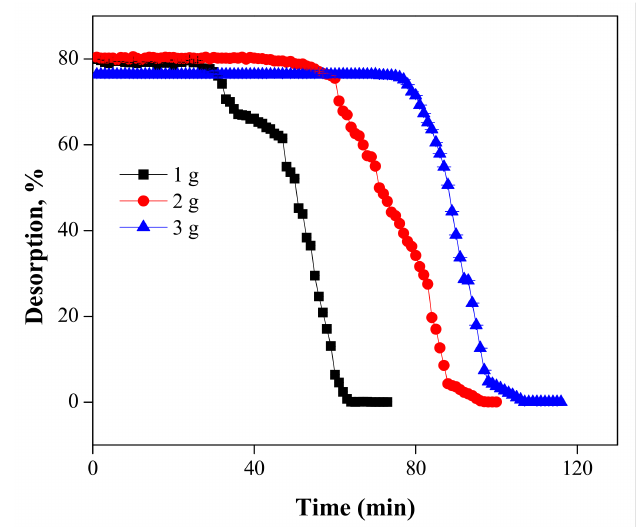
Figure 12. Desorption of Cr(VI) at various adsorbent masses using the 2 M NaOH solution. Meanwhile, the effect of various flow rates, i.e., 1, 2 and 3 mL/min was also inves- tigated at the constant adsorbent mass of 3 g. The results are displayed in Figure 13. We observed that, as the flow rate of the NaOH solution was increased (from 1 to 3 mL/min), the desired time for the recovery of Cr(VI) decreased from 186 to 47 min. The maximum recovery of Cr(VI) in each column was observed to be 70.77 ± 0.07, 74.82 ± 0.04 and 76.45 ± 0.001, with 1, 2 and 3 mL/min flow rates of NaOH.